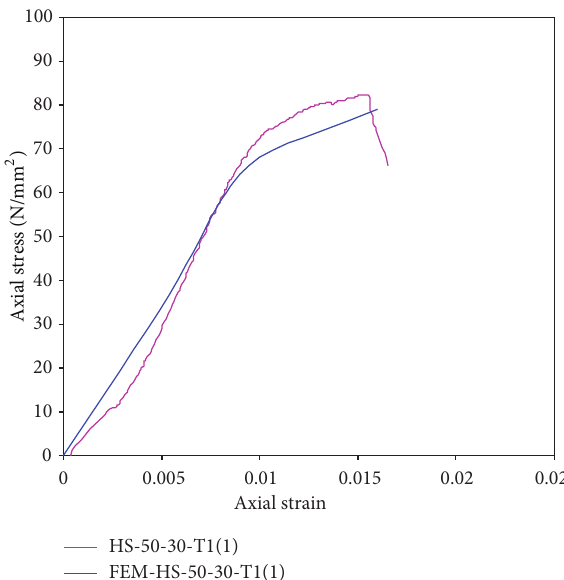
Figure 33: Comparison of experimental and computed axial stress-strain behaviours of HS-50-30-T1 (1) columns.